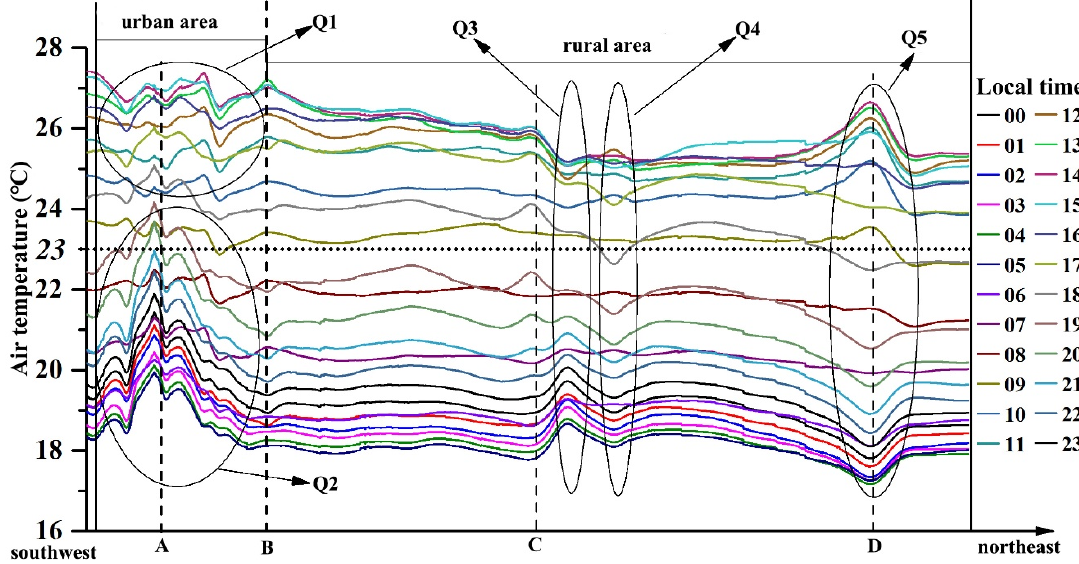
Figure 9. Air temperature profiles over 24 h in the direction from southwest to northeast (A, B, C and D are the sample weather stations, and their locations are shown in Figure